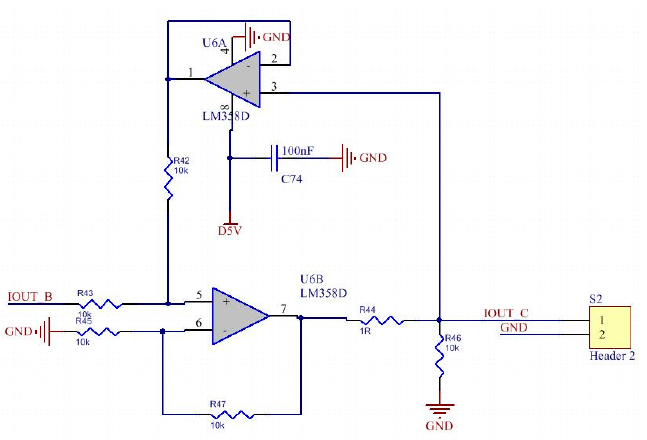
Figure 13. Constant current source circuit design.